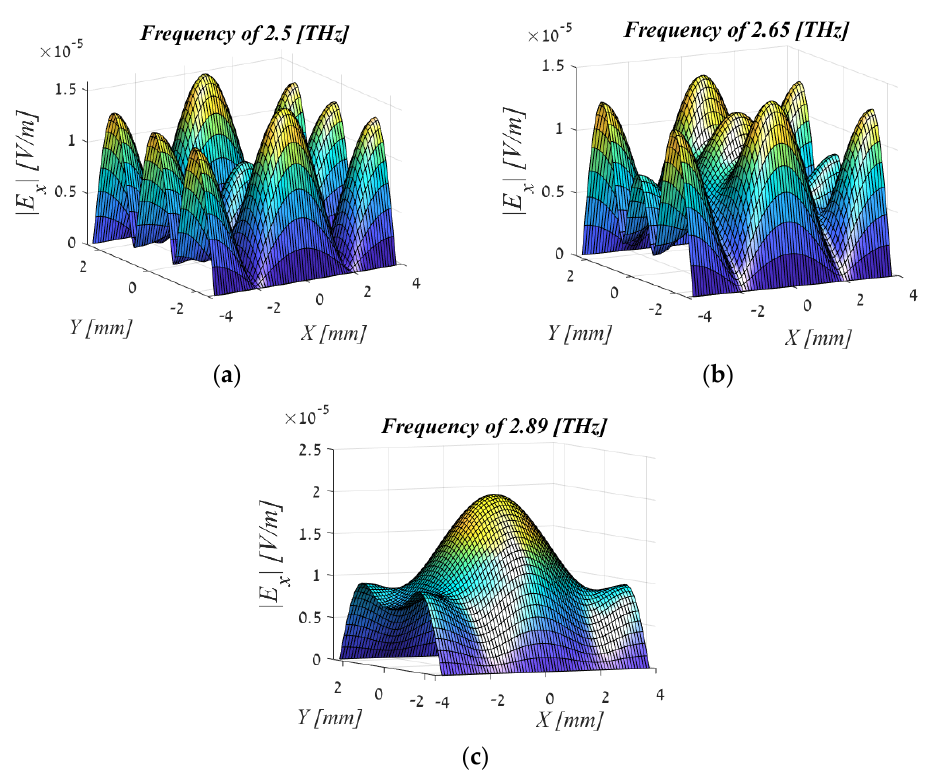
Figure 4. Spatial profile of the output radiation field: ( a ) f = 2.5 (THz), ( b ) f = 2.65 (THz), ( c ) f = 2.89 (THz). As can be seen at frequency 2.89 (THz), the energy is concentrated in the middle of the aperture and is maximum in size. Whereas, at a frequency of 2.65 (THz), the energy is smaller and what is important is that it is concentrated on the sides. At 2.5 (THz) the energy is even smaller. Since the concentration is on the sides and there is almost nothing in the middle of the aperture, we will perform the calculations for the frequency 2.89